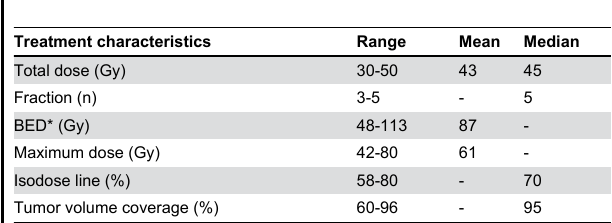
Table 1. Treatment characteristics of cyberknife for 26 patients with adrenal